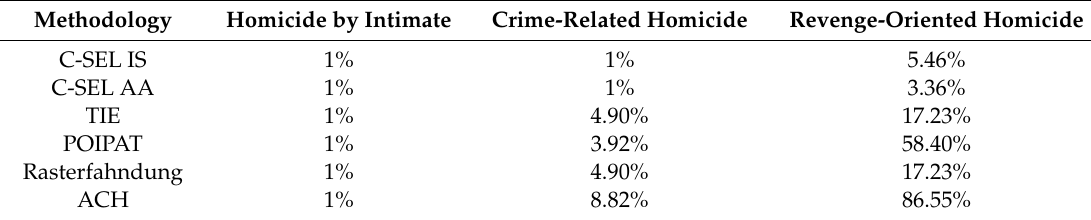
Table 5. Summary of percentages in which the perpetrator is prioritized by the initial score of the case-specific element library (C-SEL IS) alone and after adjustment of the underlying factors (C-SEL AA) as well as Trace Investigate Evaluate (TIE), Person of Interest Priority Assessment Tool (POIPAT), Rasterfahndung, and Analysis of Competing Hypotheses (ACH). The percentages for TIE, POIPAT, Rasterfahndung, and ACH were taken from Sutmuller et al. [18]. Methodology Homicide by Intimate Crime-Related Homicide Revenge-Oriented